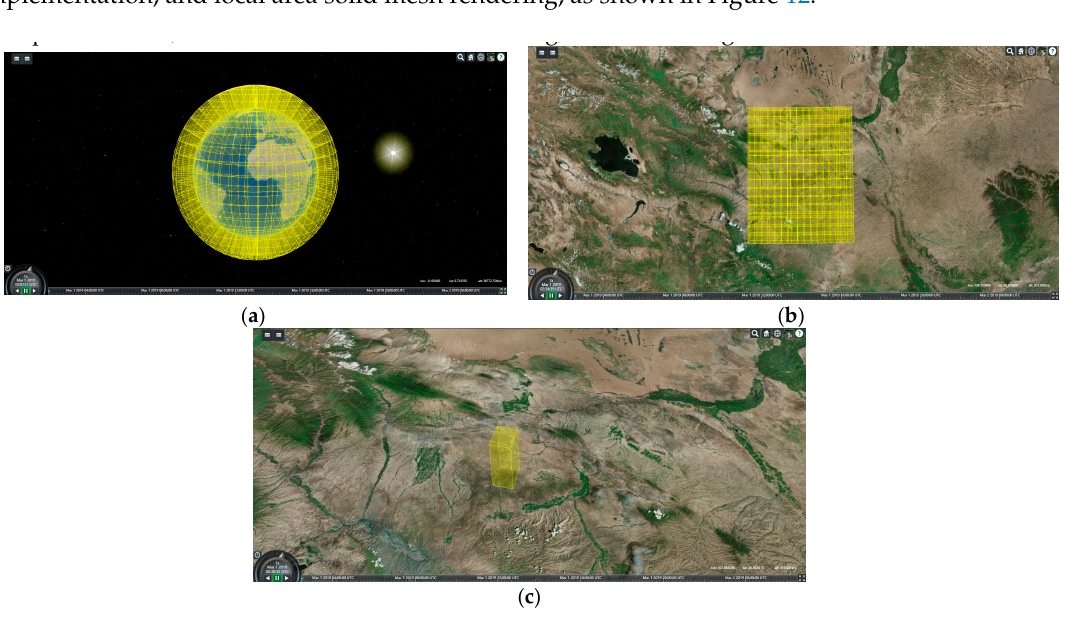
Figure 12. This is the GeoSOT global split stereo grid implementation. ( a ) 6-level GeoSOT global split stereo grid. ( b ) Local area GeoSOT globally split stereo grid. The level, latitude, and longitude parameters are (12, [35.5555, 37.5860], [103.1827, 105.2057], [0,50]). ( c ) Any level, latitude, longitude, and elevation, a single GeoSOT global split stereo grid. The level, latitude, longitude and elevation parameters are (12, 36.546219, 104.164491,